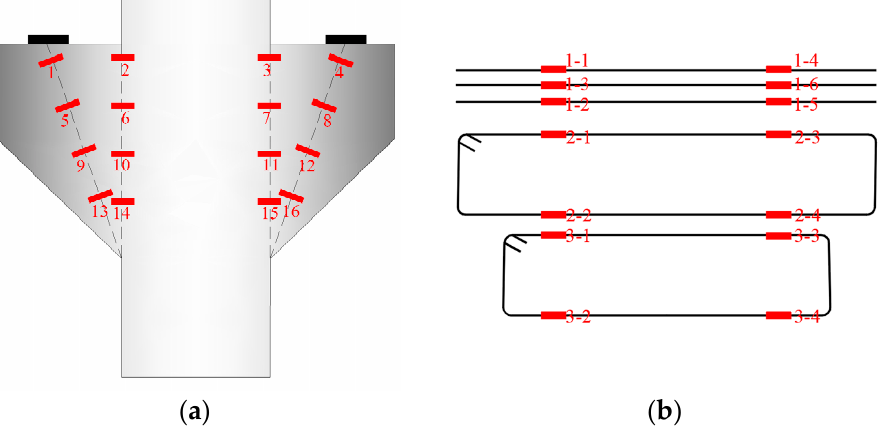
Figure 2. Strain gauge layout of concrete and steel. ( a ) Strain gauge layout of concrete. ( b ) Strain gauge layout of steel.